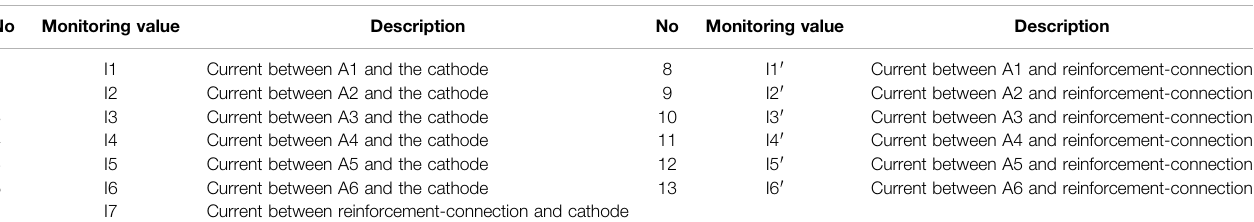
TABLE 2 | Current values collected by the anode-ladder sensor.